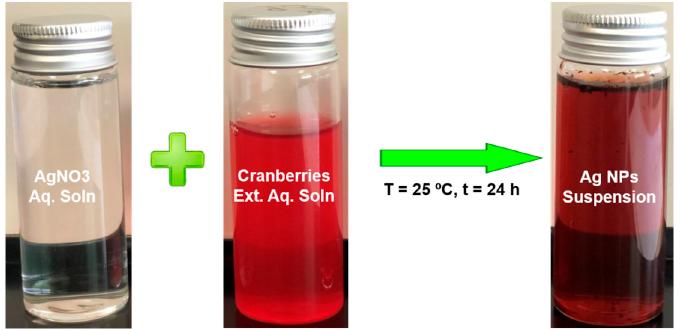
Figure 1. Image of aqueous solution of AgNO 3 , V. oxycoccos (cranberries) aqueous extract, and suspension after 24 h of stirring at room temperature.